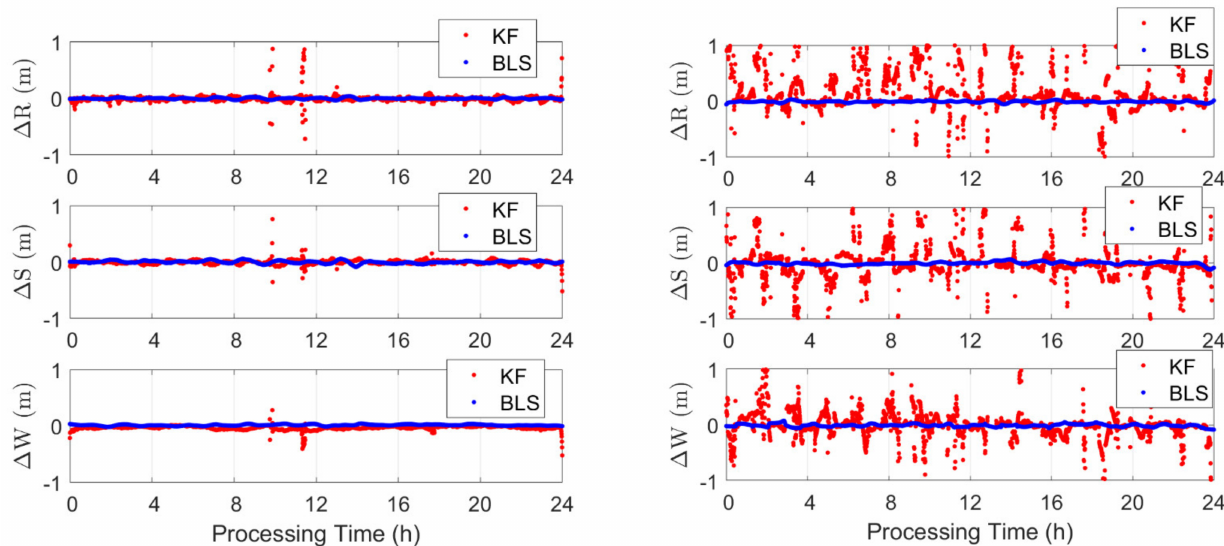
Figure 1. Orbital errors processed with the Kalman Filter (KF) in real-time and the Batch Least- Squares (BLS) adjustment in near-real-time. The data of GRACE C on 14 August 2018 ( left ) and 12 August 2022 ( right ) were processed using the CNES real-time GNSS